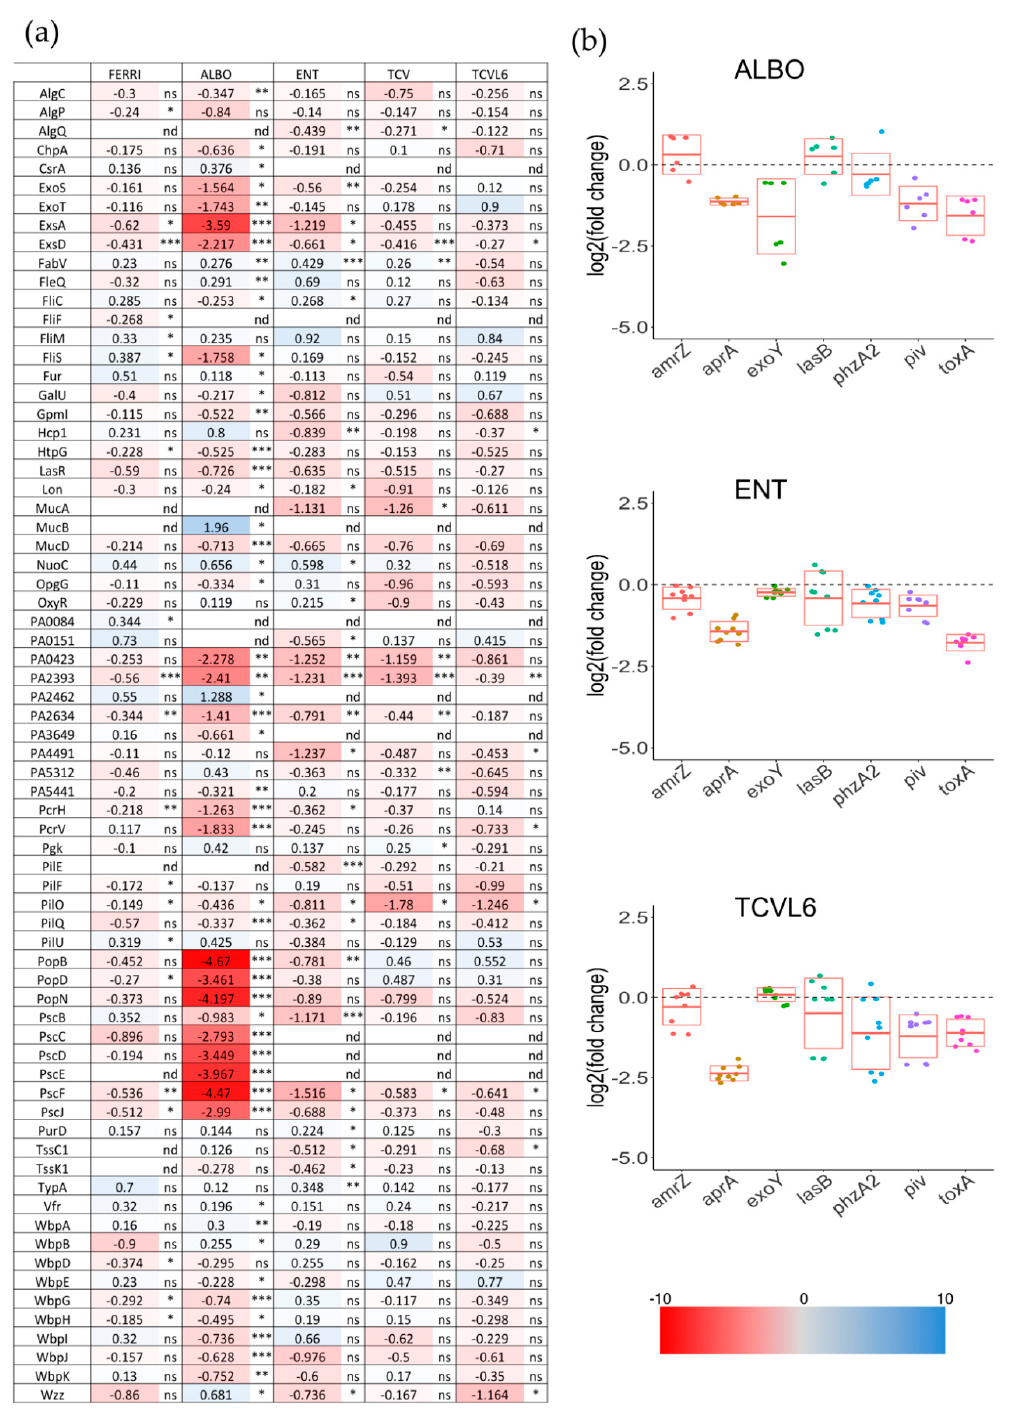
Figure 7. ( a ) Analysis of changes in the expression of virulence factors in P. aeruginosa cells during A549 epithelial cell infection, in the presence or absence of FERRI, ALBO, ENT, TCV, or TCVL6. Proteomic analyses were performed on P. aeruginosa PAO1 cells as in Figure 5. Median values measured in the infection assay supplemented with either 10 µ M FERRI, ALBO, ENT, TCV, or TCVL6 were plotted against those measured in the infection assay in the absence of supplementation with siderophore or siderophore–antibiotic compounds. The median values represent the median of the relative intensity of each protein normalized against all proteins detected by shotgun analysis (n = 5). The darker the shade of blue, the higher the induced expression of the protein. The darker the shade of red, the higher